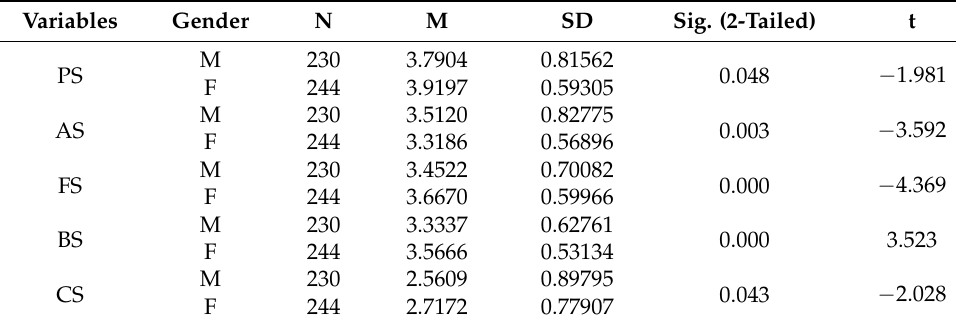
Table 9. Differences between